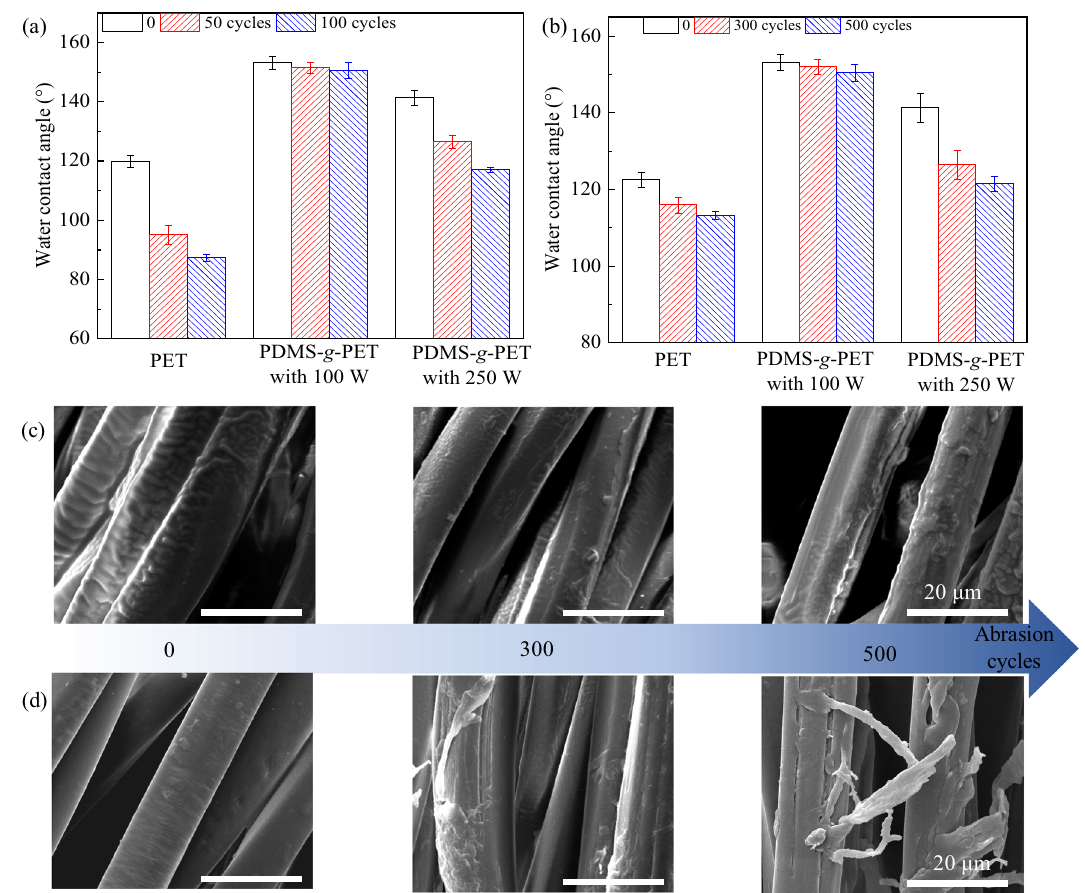
Figure 3: ( a ) Washing durability and ( b ) abrasion stability of PET and PDMS - g - PET fabrics with di ff erent RF powers; surface morphology of PDMS - g - PET fabrics after di ff erent abrasion cycles with RF power of ( c ) 100 W and ( d ) 250